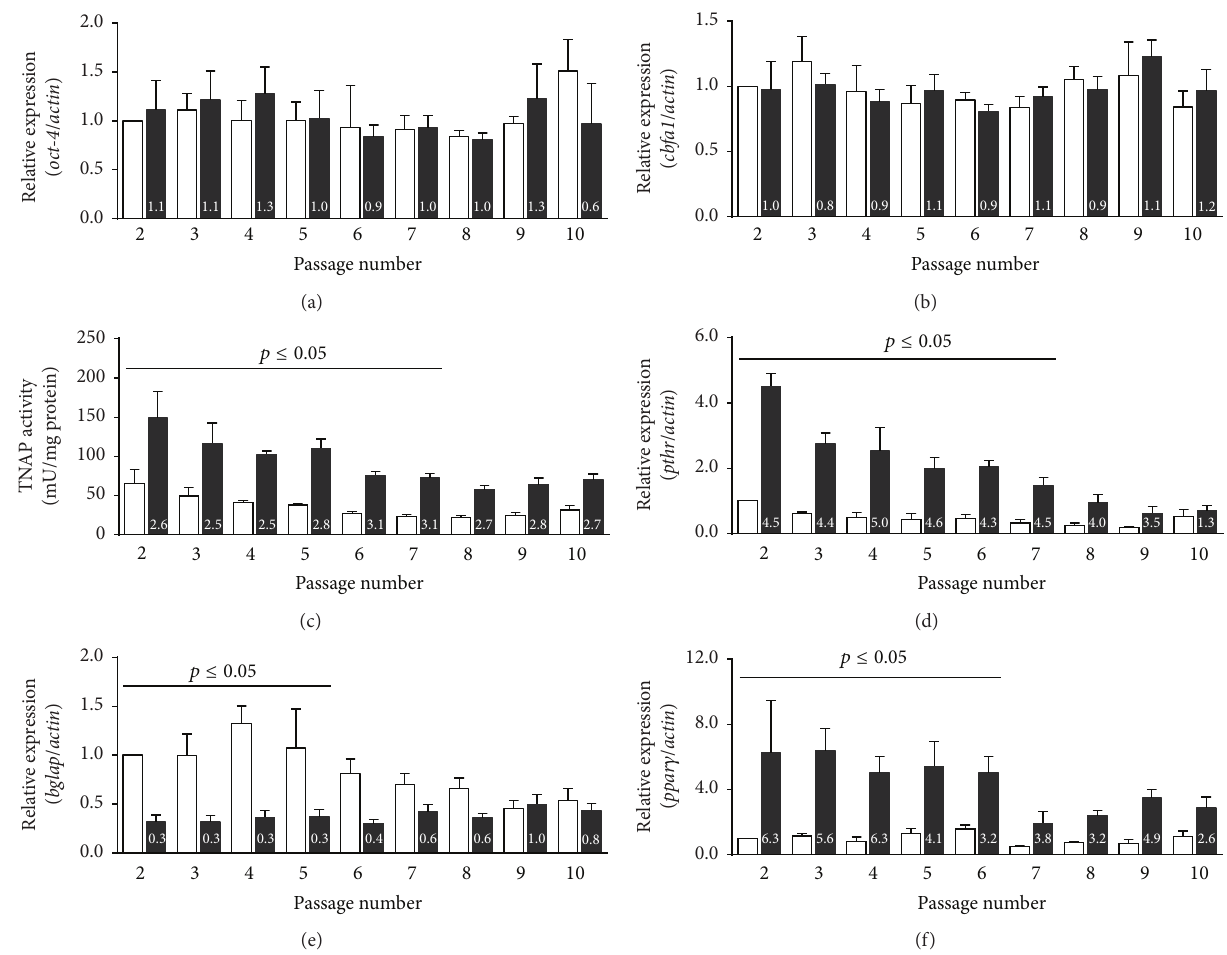
Figure 6: Influence of passaging on hBMSC differentiation. hBMSC in passage 1 until passage 9 were plated in BM (basic medium, white columns) onto TCPS (= P2–P10 for the analyses). From day 4 after plating, the cells were cultured either in BM or in OM/D (osteogenic differentiation medium, black columns). At day 15 after plating, the cells were analyzed for expression of oct-4 (a), cbfa1 (b), pthr (d), bglap (e), and ppar 𝛾 (f), and for TNAP activity (c) as described above. Relative gene expression (gene of interest) was assessed by real time PCR and normalized to the expression of beta-actin as house-keeping gene by comparative quantitation analysis setting passage 2 value in BM = 1. Small digits in the black columns (OM/D) indicate the inducibility of the parameter in each passage as quotient OM/D :BM. Significant differences of OM/D versus BM for each passage were analyzed by two-way ANOVA with Bonferroni’s post-test and indicated ( 𝑝 ≤ 0.05 ), 𝑛 = 4